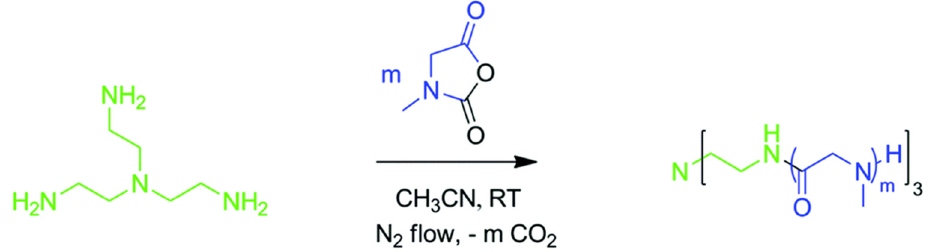
Figure 15. Synthesis of star-shaped poly(sarcosine)s using TREN as initiator (Adapted from ref. [87]. Copyright 2017, Royal Society of Chemistry).